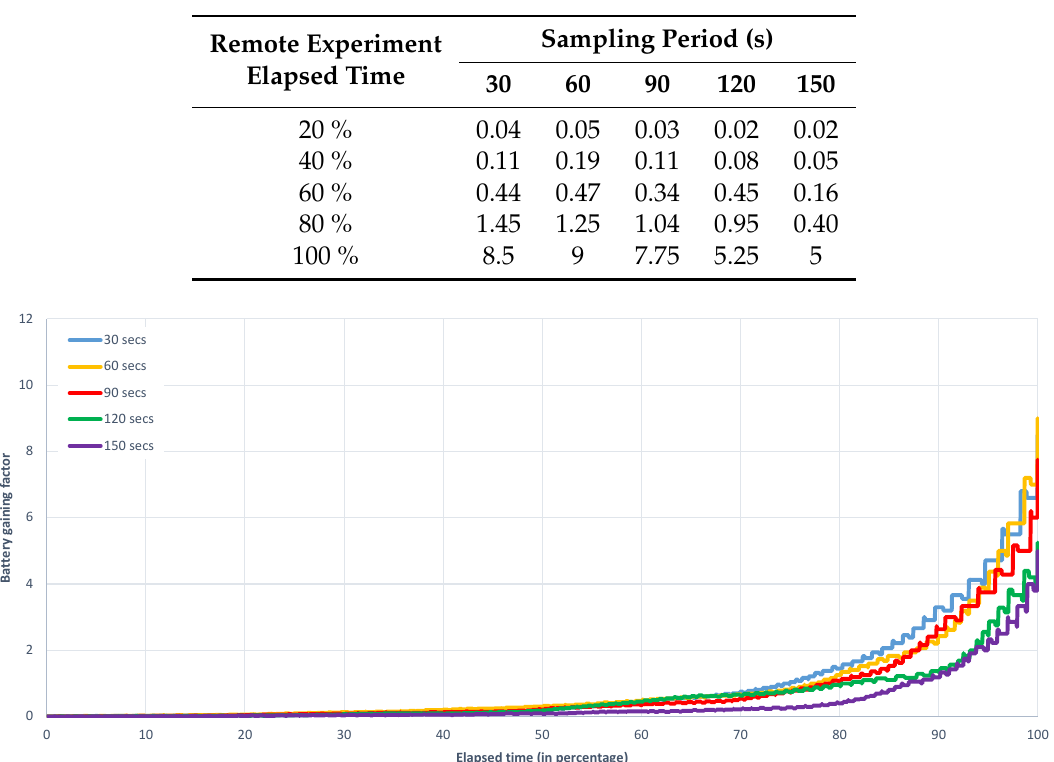
Table 4. Battery gains of the on-device approach vs MCC oriented solution across time, as observed during experiment two.